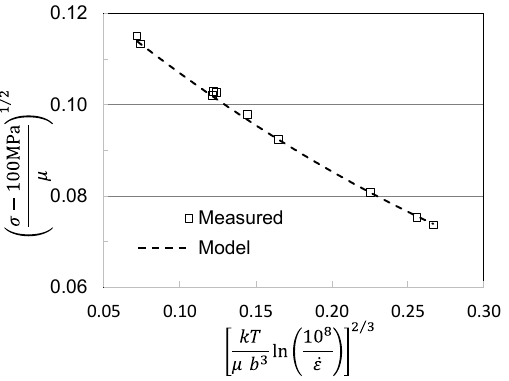
Figure 5. Stress–strain curves at various temperatures and strain rates in Follyalloy in the “Material Supplied” condition.